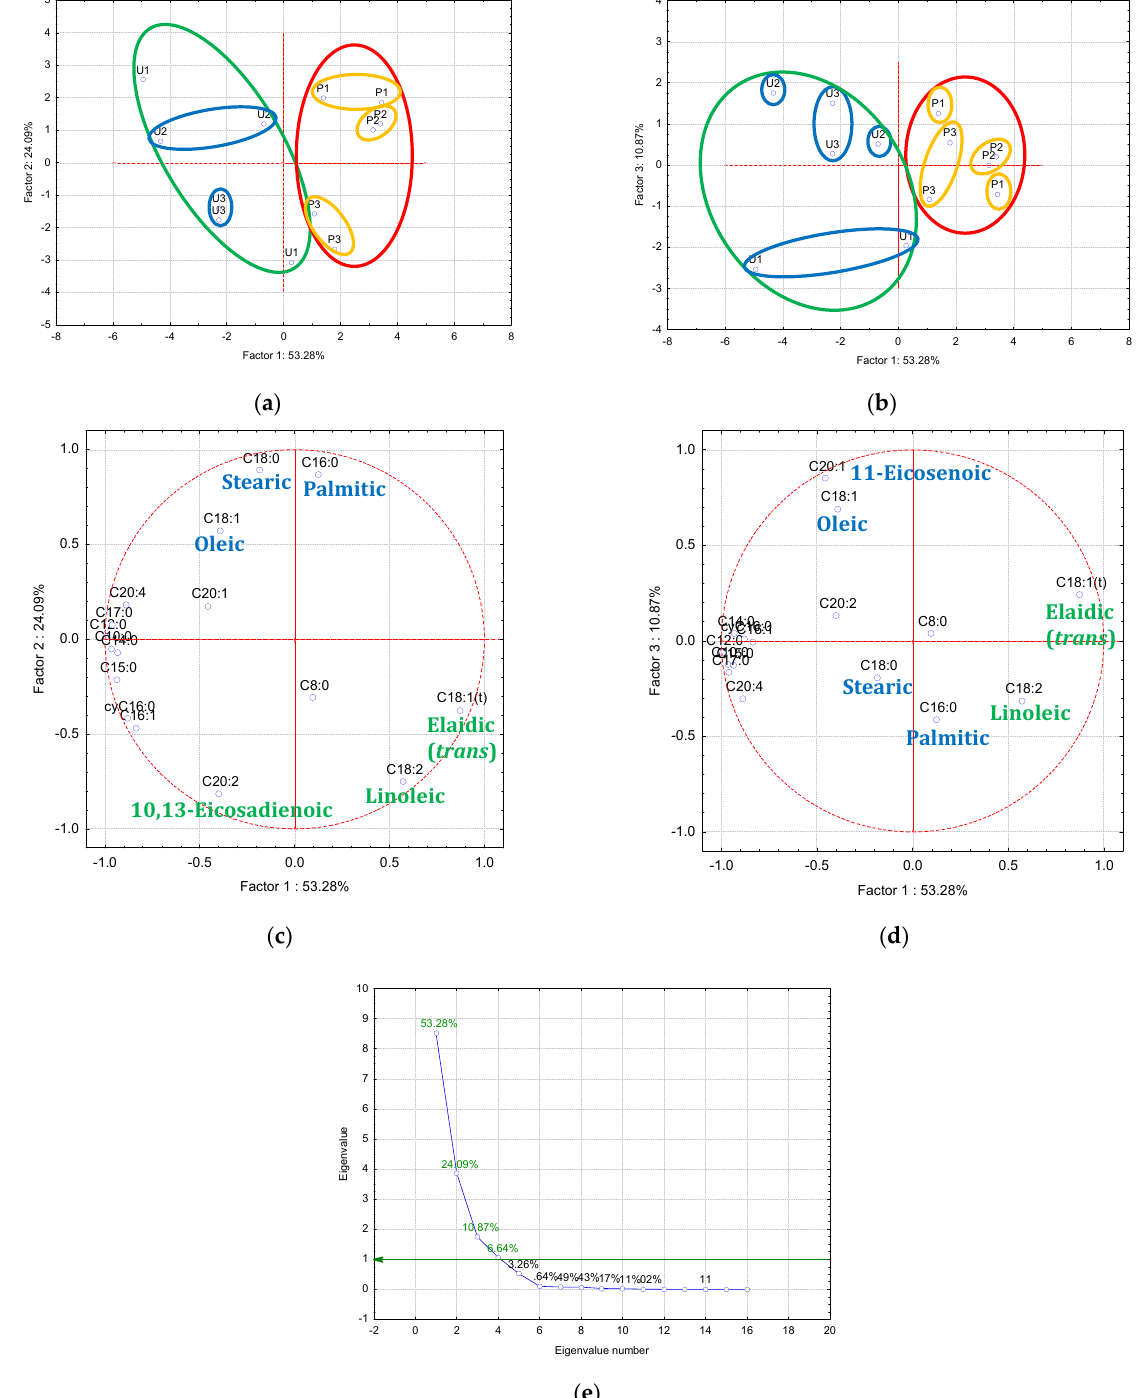
Figure 10. Principal Component Analysis (PCA) results for the gas chromatography-mass spectrometry (GC-MS) data of the derivatized lipid fractions from Mangalitza hard fat (relative concentrations data for specific fatty acid methyl esters, see Table 1 for codes. PC 1–3 stand for Factors 1 to 3): ( a ) PC 2 versus PC 1 scores plot, ( b ) PC 3 versus PC 1 scores plot, ( c ) PC 2 versus PC 1 loadings plot, ( d ) PC 3 versus PC 1 loadings plot, ( e ) Eigenvalues of the correlation matrix (Principal Components, PCs, with significant influence to the explained variance are presented in green. Only a few PCs are sufficient to explain the variance of the data. In this case, the first four PCs explain 94.89% of the variance (instead of 16 raw variables). PCs with eigenvalues greater than 1 in the correlation matrix are considered to have a significant influence to the explained variance in the PCA technique). For other PCA results, see Supplementary material file (Tables S1–S6 and Figures S13– S16).